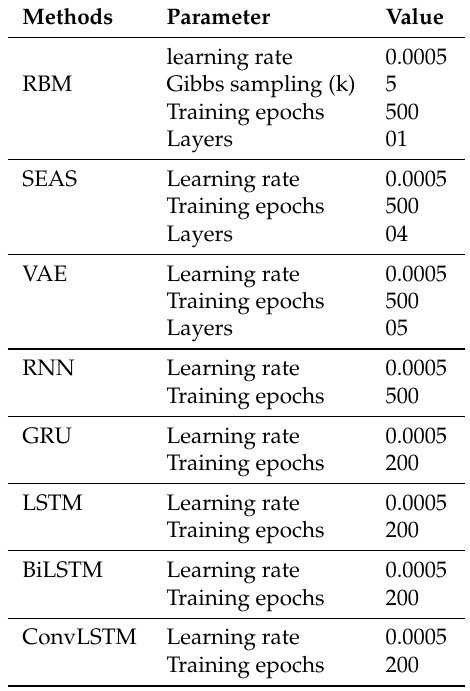
Table 2. Tuned parameters in the considered